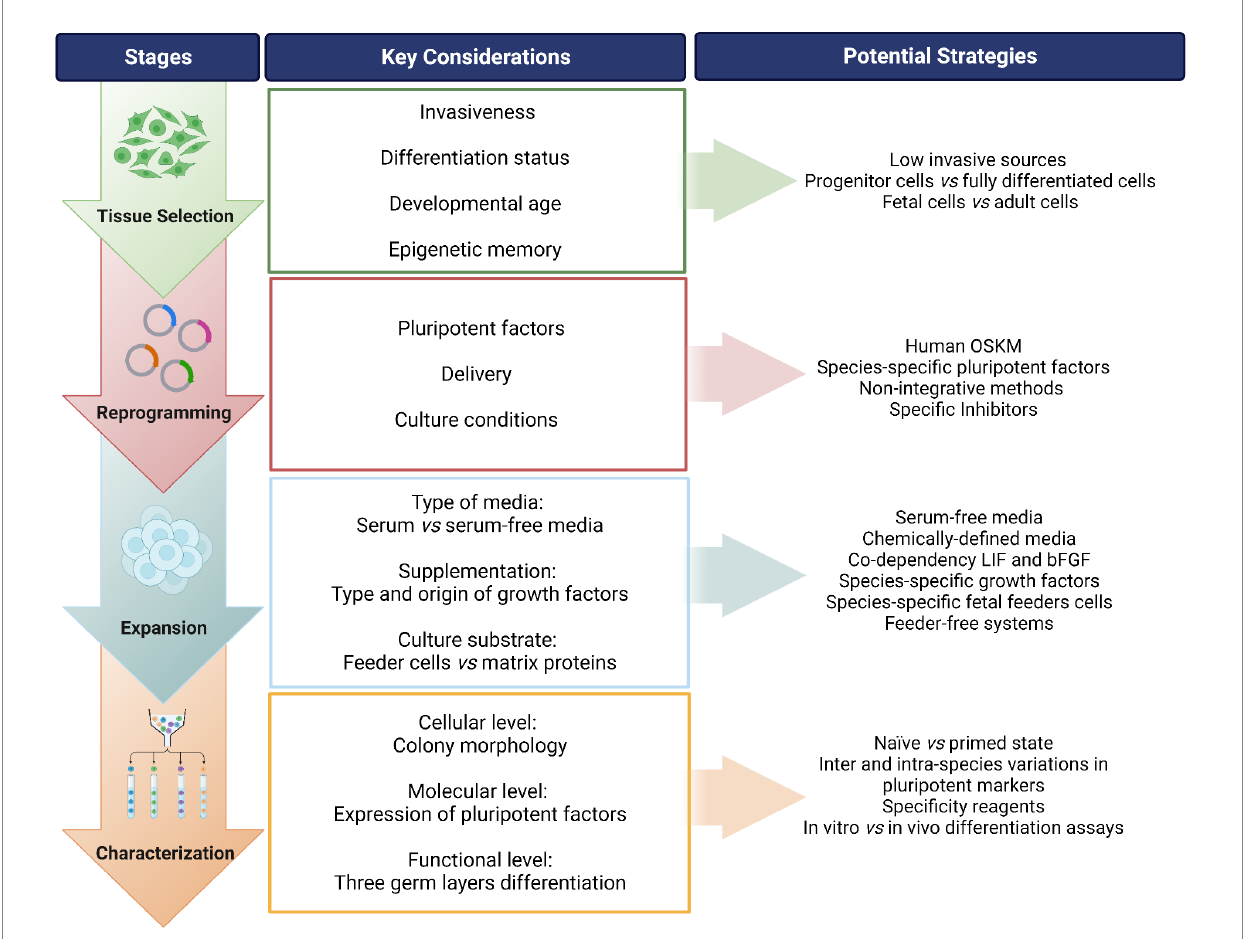
FIGURE 1 Overview of the process for generating induced pluripotent stem cells (iPSCs) from companion animals. A “step-by-step” flow is presented identifying the stages of the process, along with the key considerations in each step and suggested potential strategies to address each point. OSKM: Oct-4, Sox- 2, Klf-4, c-MYC; i.e., Yamanaka factors. LIF, leukemia inhibitory factor; bFGF, basic fibroblast growth factor. Created with